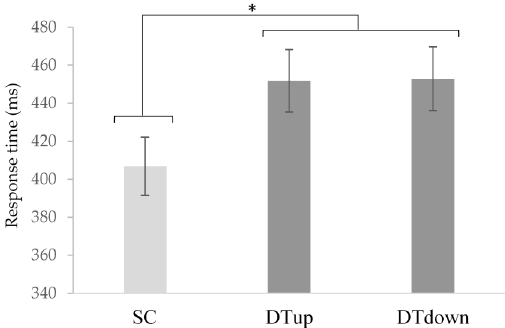
Figure 5. Mean vocal response times between single cognitive (SC) and dual-task (DT) up and down blocks. Response times were significantly slower during dual- compared to single tasks F (2,38) = 16.451, p < 0.001, η 2 = 0.464. (*) indicates significance p < 0.001 and error bars represent standard error of the